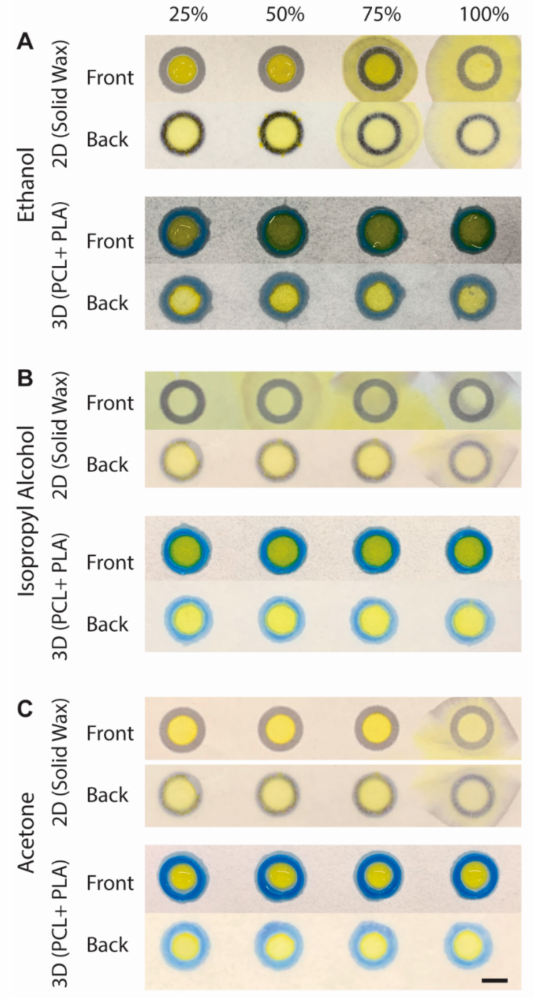
Figure 4. Solvent containment in 3D-PAD. An amount of 30 µ L of 25–100% of ( A ) ethanol ( B ) isopropyl alcohol (IPA) and ( C ) acetone placed on 2D wax wells and 3D wells. Both front and back sides of the device are shown. Scale bar = 400 µ